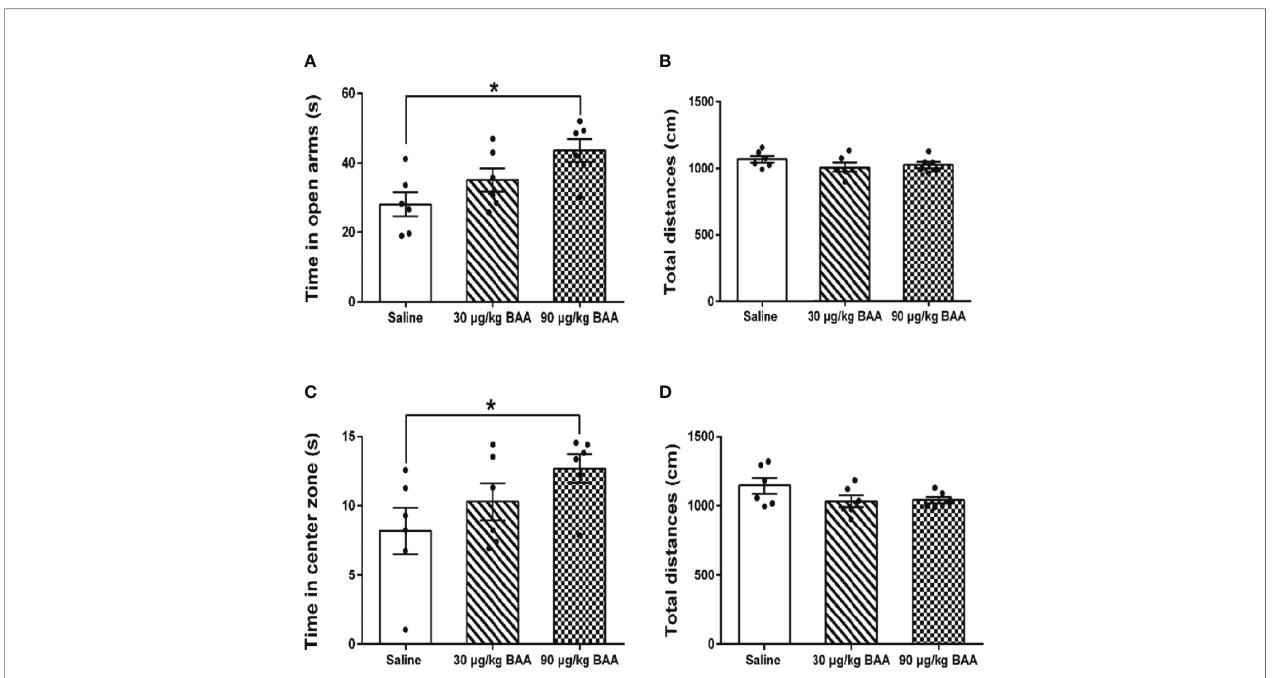
FIGURE 6 | The antianxiety effects of Bulleyaconitine A (BAA) on visceral pain-anxiety comorbidity of heterotypic intermittent chronic stress (HeICS) rats. (A , C) The antianxiety effects of BAA on anxiety model rats in elevated plus maze (EPM) and open fi eld test (OFT) (n = 6 each; one-way ANOVA; * P < 0.05 90 m g/kg BAA vs. 1